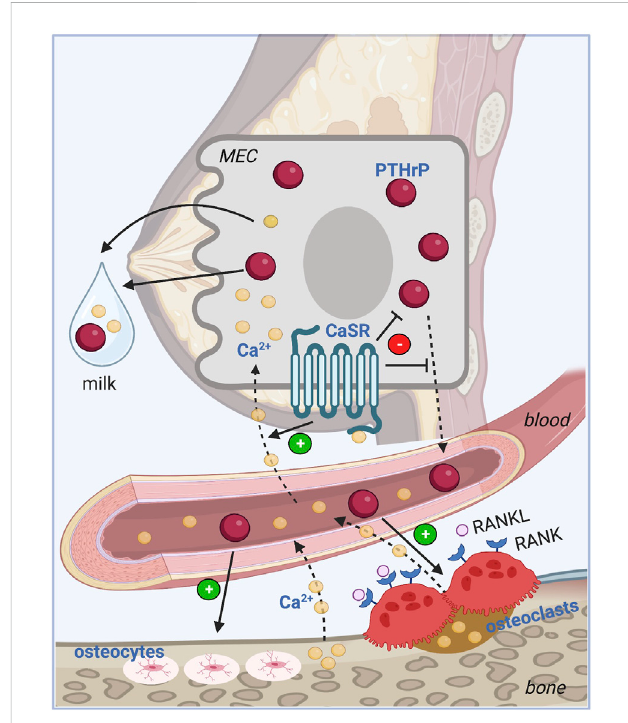
FIGURE 2 Calcium sensing feedback loop between bone and breast. PTHrP regulates calcium homeostasis during lactation in a classic endocrine feedback loop. PTHrP is secreted from the mammary epithelial cells (MEC) into the circulation and stimulates osteoclastic and osteocyticboneresorptionfromtheskeleton. Thefreecalciumreleased into the bloodstream feeds back to the mammary gland where it activates the CaSR on the MEC to promote transepithelial transport of calcium into milk, and to inhibit further production and secretion of PTHrP into the circulation. MEC: Mammary epithelial cell, PTHrP: Parathyroid hormone-related peptide, CaSR: Calcium sensing receptor, RANKL: Receptor activator of NF-KB ligand, RANK: Receptor activator of NF-KB; Ca 2+ : Ionized calcium. Image made with